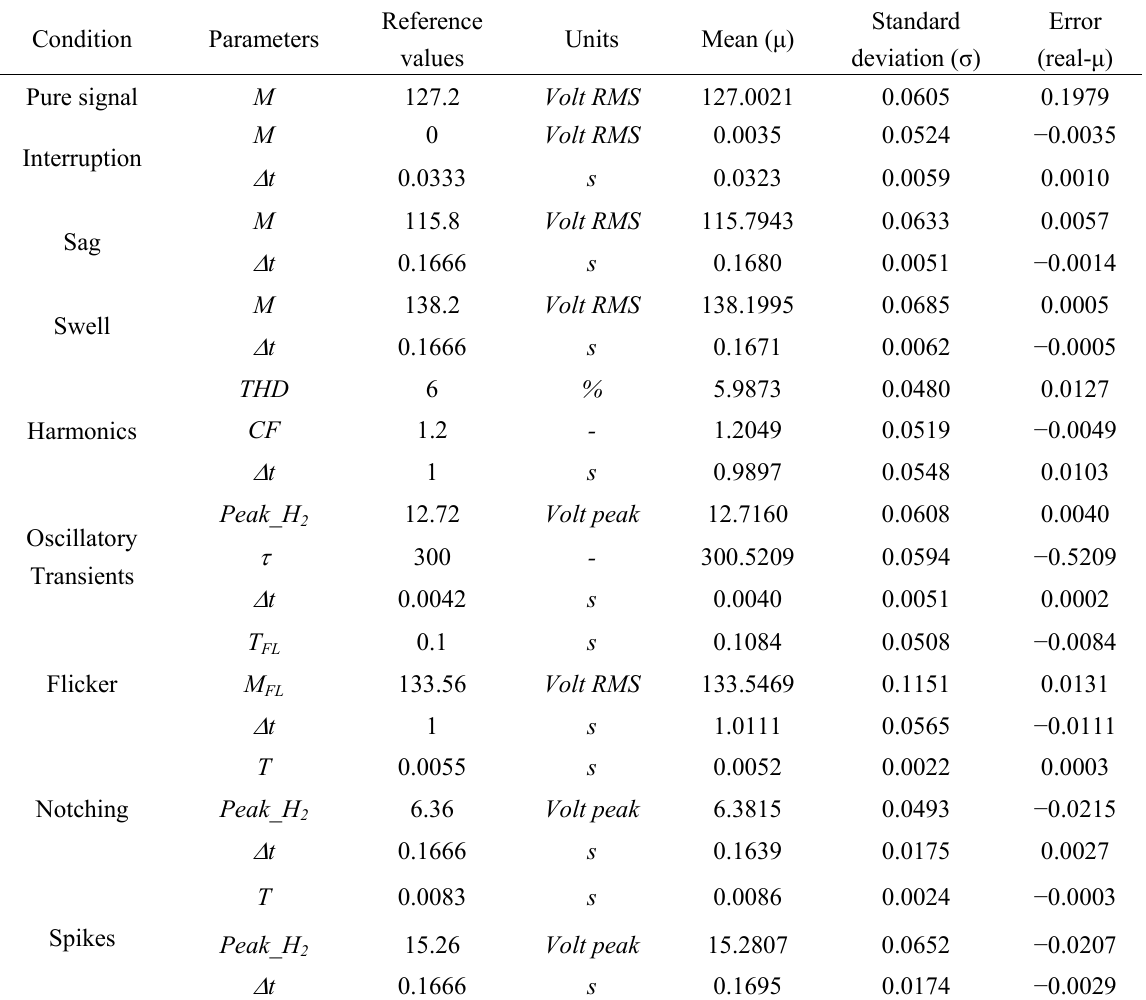
Table 7. Smart sensor performance under real operating